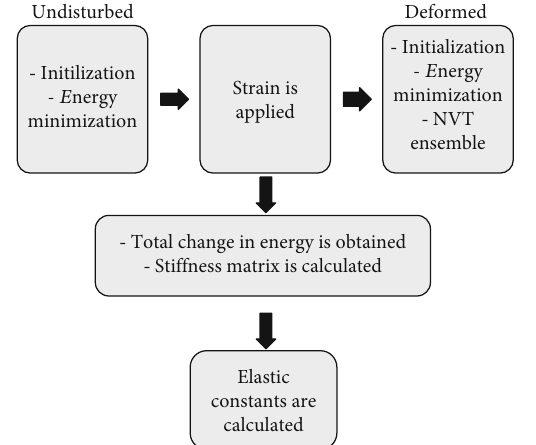
Figure 6: LAMMPS-based molecular approach used to calculate mechanical properties.